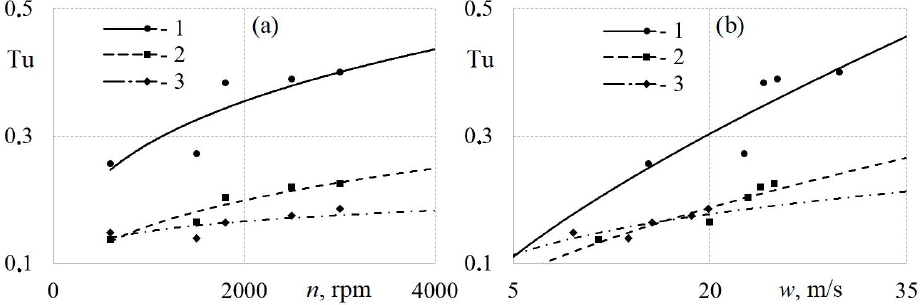
Figure 9. Dependences of the degree of turbulence Tu of the flows on the crankshaft speed n ( a ) and the average flow velocity w ( b ) in the intake system with channels of different diameters: 1— d = 26 mm; 2— d = 32 mm; 3— d = 40